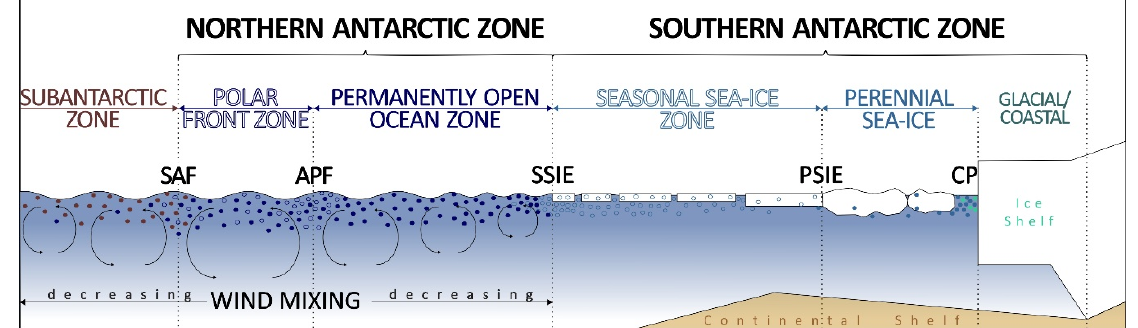
Figure 4. Diagram of oceanographic zones of the Southern Ocean (SAF—Subantarctic Front; APF—Antarctic Polar Front; SSIE—seasonal sea-ice extent; PSIE—perennial sea-ice extent; CP—Coastal Polynya). Coloured circles represent diatom productivity (increased density of circles corresponds to higher productivity); colours represent ecologically distinct diatom assemblages associated with the oceanographic zones (adapted from Allen et al. [59]). Table 1. Summary of diatom identifications.